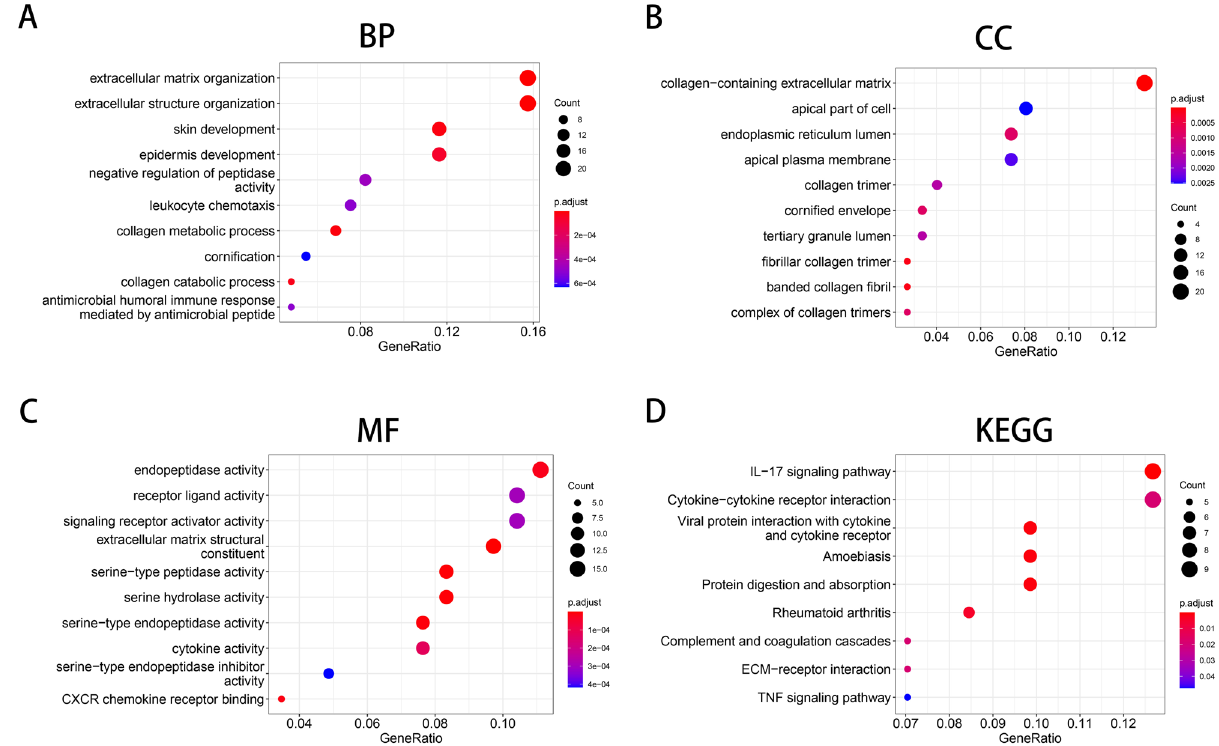
Figure 3. GO and KEGG pathways enriched with the robust DEGs in ESCC. ( A ) Biological process terms enriched with the robust DEGs. ( B ) Cellular component terms enriched with the robust DEGs. ( C ) Molecular function terms enriched with the robust DEGs. ( D ) KEGG analysis of the robust DEGs. The respective pathway involved in ESCC was identified by using the KEGG pathway database (https:// www. kegg. jp/ kegg/ pathw ay. html). GO, Gene Ontology; KEGG, Kyoto Encyclopedia of Genes and